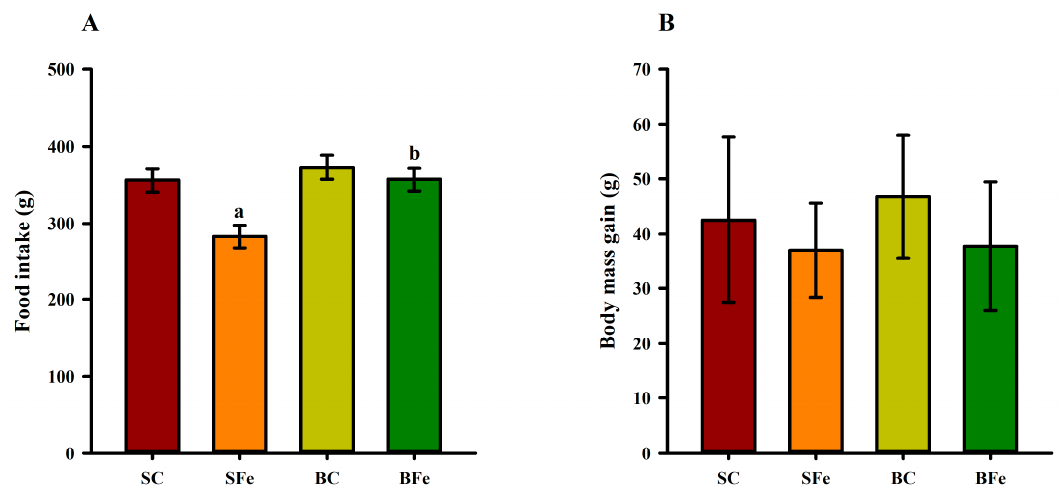
Figure 1. Food intake ( A ) and body mass gain ( B ) of rats treated or not with a high dose of FeSO 4 and diets added with either soybean oil or buriti oil. SC = control group fed a diet containing soybean oil and gavage with saline solution; BC = control group fed a diet containing buriti oil and gavage with saline solution; SFe = group fed a diet containing soybean oil and gavage with a high-dose FeSO 4 ; BFe = group fed a diet containing buriti oil and gavage with a high-dose FeSO 4 . a Represents a significant difference compared with the SC; b Represents a significant difference compared with the SFe. Values in the vertical bars are mean ± SD of each rat group (Student’s t -test, p ≤ 0.05; n = 8 rats/group).